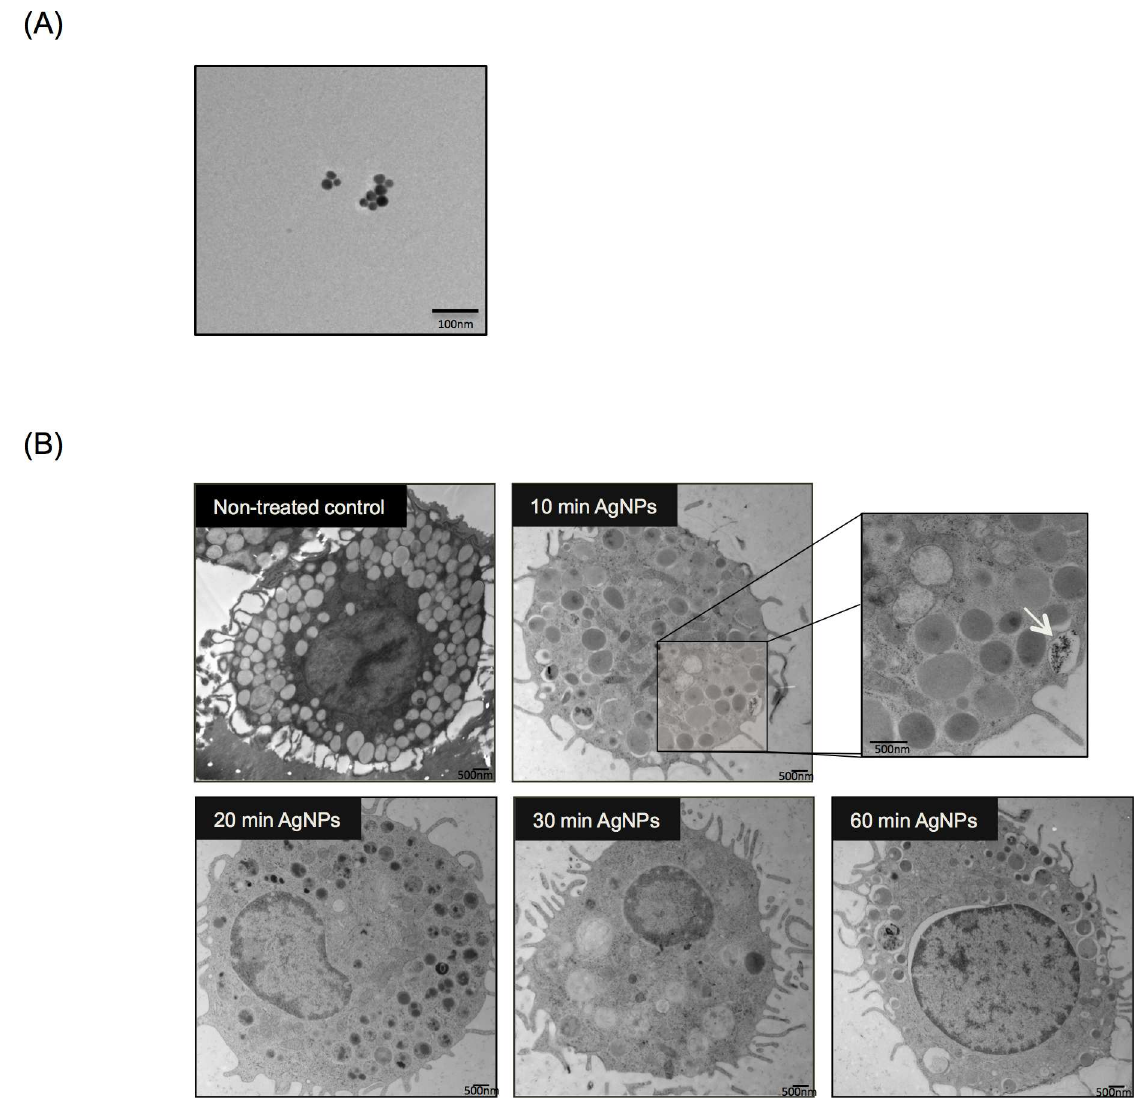
Fig 1. Time Course of Mast Cell Association of AgNPs (A) Representative Transmission Electron Microcopy (TEM) image demonstrating AgNP shapeand size. (B) Representative TEM images of mast cells followingexposure to 20 nm AgNPs over time. Mast cells were treated with AgNPs (25 μ g/ml) for 10, 20, 30 and 60 min and AgNPs uptake by mast cells was assessed. Arrow indicates AgNPs that were being taken up by a mast cell (inset). A representative image was obtainedfrom at least 5 different